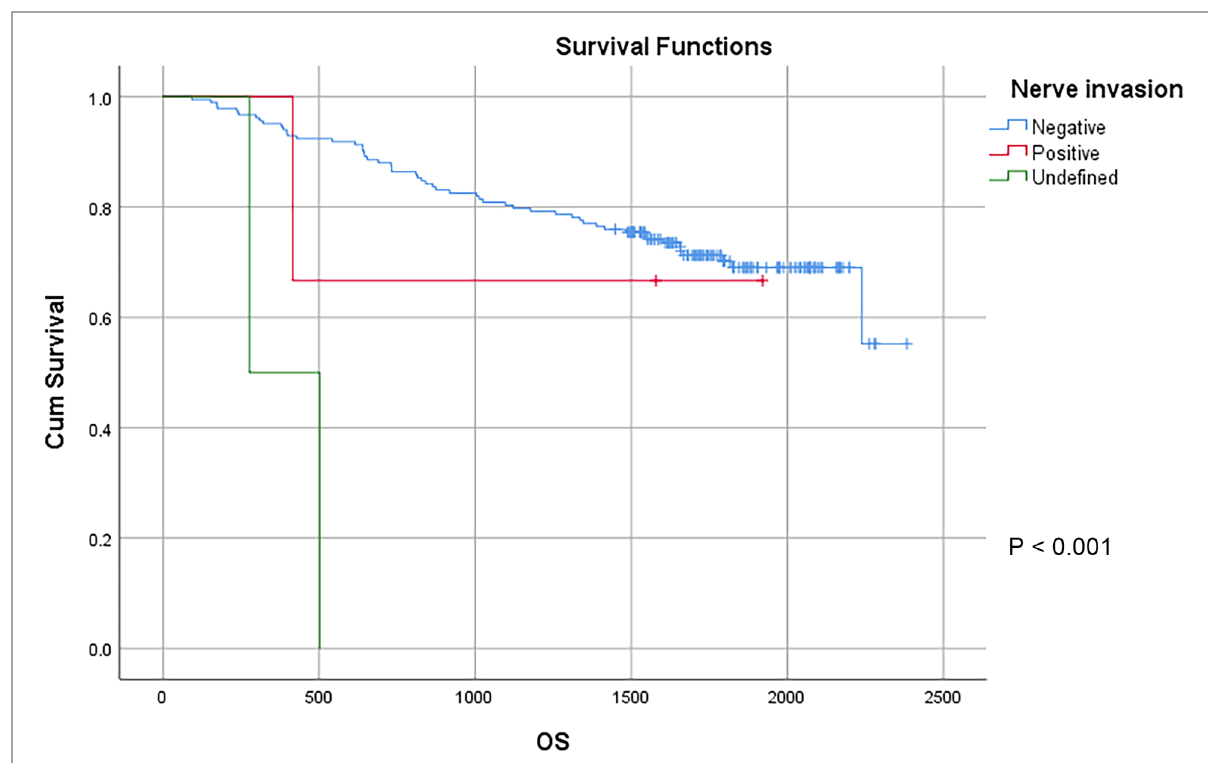
FIGURE 4 Survival curves of colon cancer patients in different nerve invasion groups.